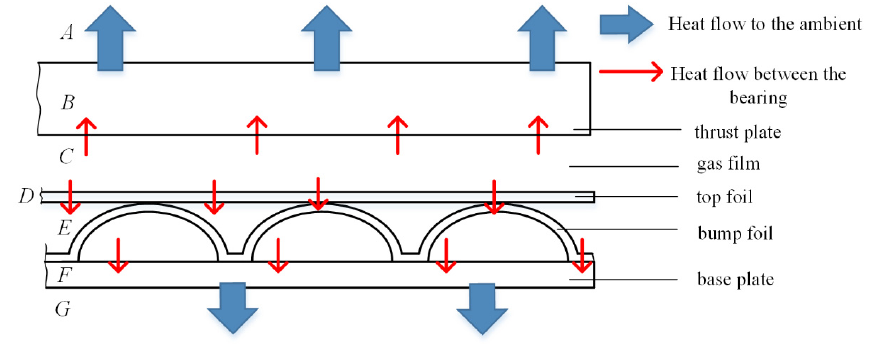
Figure 2. Heat flow transfer model.